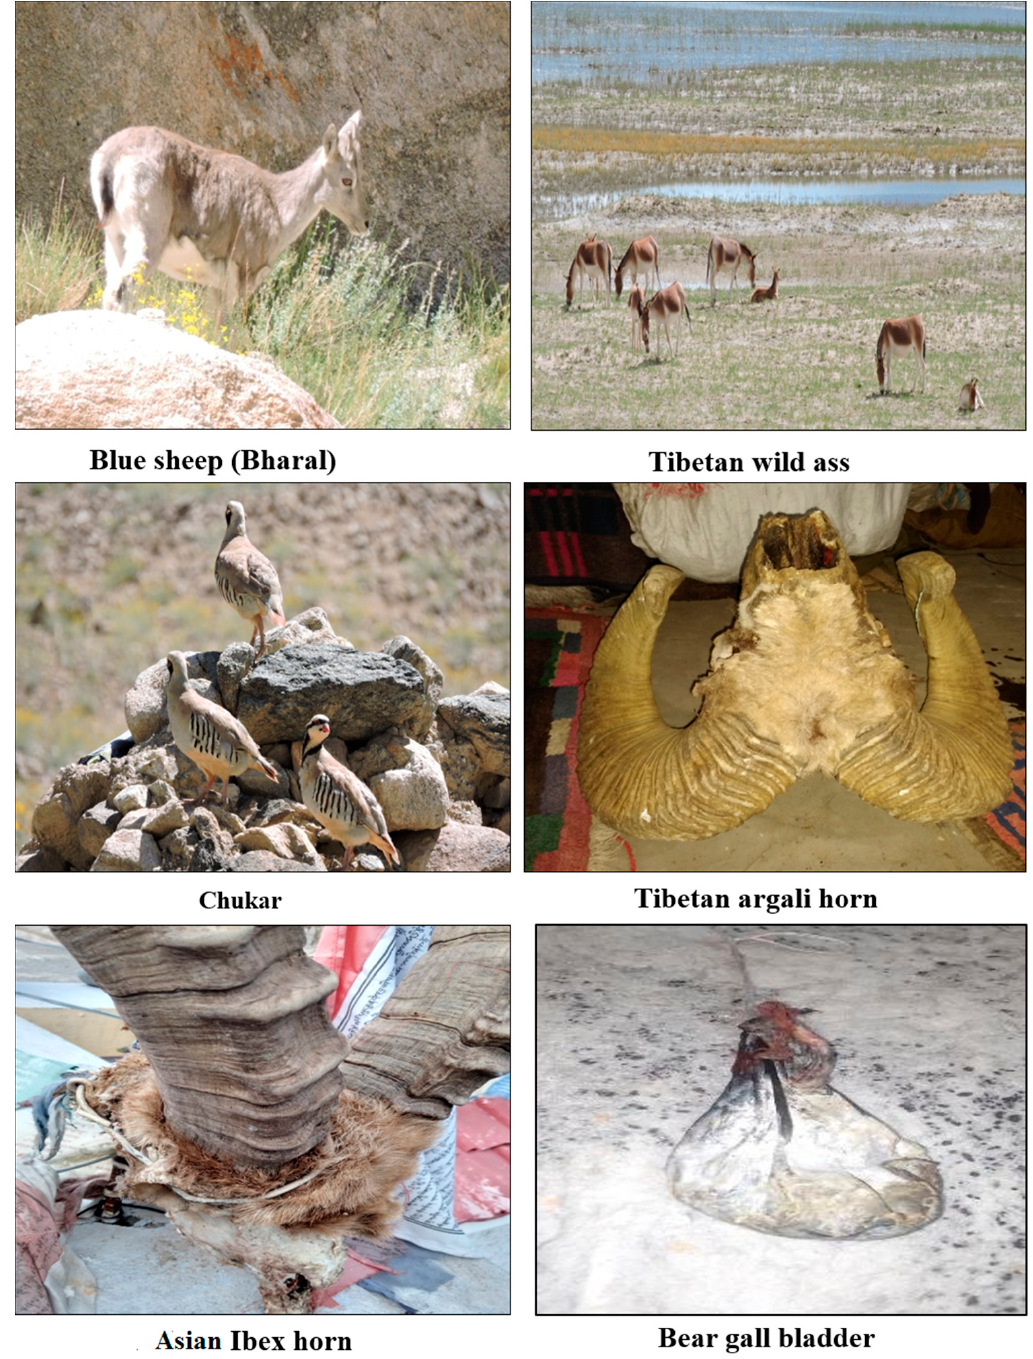
Figure 4. Fauna / parts sited during field Figure 4. Fauna/parts sited during field study.